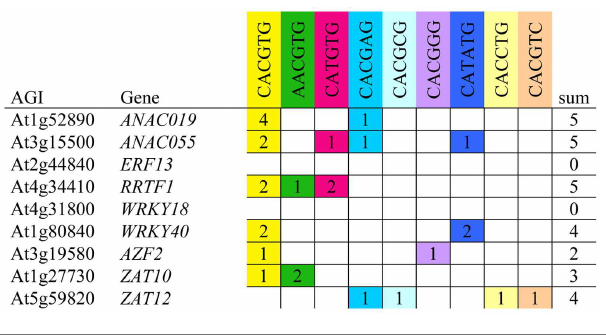
FIGURE 6 | Expression of insect-inducible transcription factors in coi1-1 and myc234 . Expression ofTFs was measured by qRT-PCR in untreated plants (white bars) and in plants challenged for 48h with S. littoralis larvae